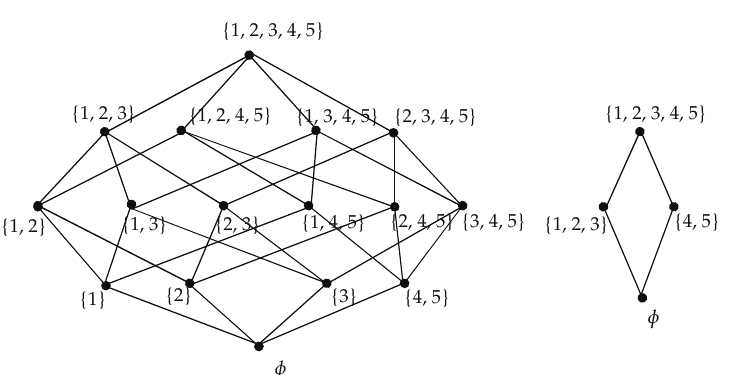
Figure 1: The lattice of L (cid:5) M (cid:5) C (cid:6)(cid:6) (cid:5) resp., L XH (cid:5) M (cid:5) C (cid:6)(cid:6)(cid:6) and L SH (cid:5) M (cid:5) C (cid:6)(cid:6)